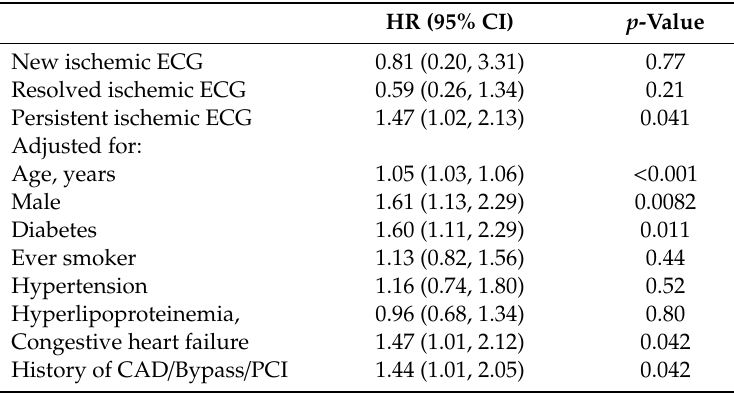
Table 4. Adjusted hazard ratios for composite endpoint.